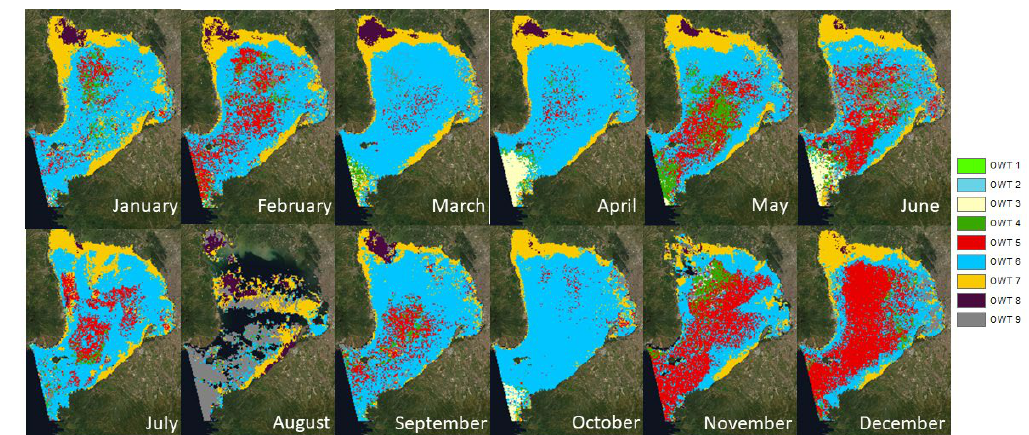
Figure 3. OWT classes in Manila Bay for 2019. OWT 7 is consistently present in the nearshore areas where the major river systems meet the bay. OWT 6 dominates the bay for most of the year except during transition between the seasons. OWT 8 is almost exclusively found at the mouth of Pampanga River except in August.